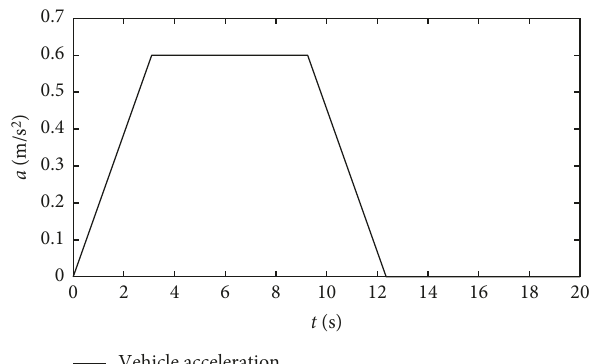
Figure 7: Acceleration curve during vehicle turning.